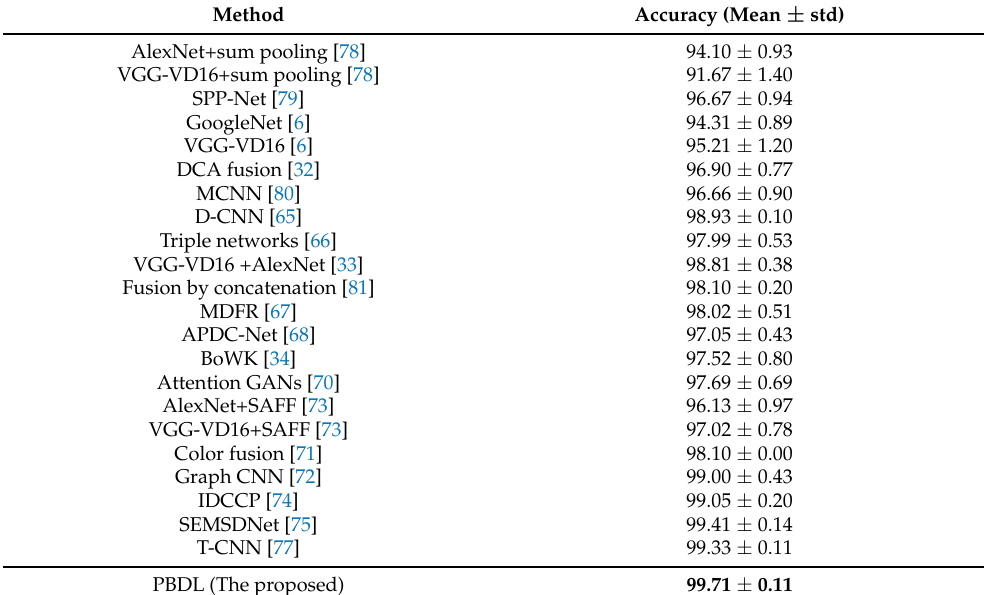
Table 7. Comparison of classification accuracy (%) for the UC-Merced dataset with 80% ratios. The results are obtained directly from the corresponding